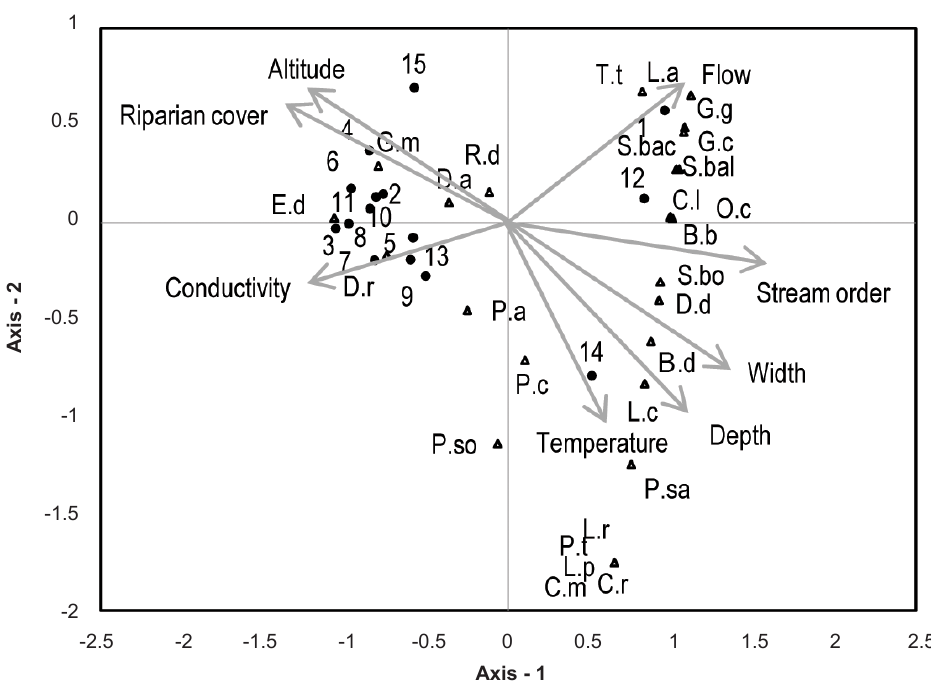
Figure 3. Canonical Correspondence Analysis (CCA) biplot depicting the distribution of fish species along the environmental parameters in 15 study sites in Panna landscape, Madhya Pradesh. [Site labels: 1- Gahrighat; 2- Gehranala; 3- Jamunahi; 4- Imalia; 5- Bargadi; 6- Mahuapani; 7- Keerpani; 8- Ghatera; 9- Nararan; 10- Kheriya; 11- Silatanala; 12- Magradabri; 13- Judinala; 14- Madla; 15- Pandav Falls. Species codes: B.d - Bangana dero ; B.b - Barilius bendelisis ; C.m - Cirrhinus mrigala ; C.r - Cirrhinus reba ; G.c - Gibelion catla ; D.r - Danio rerio ; D.a - Devario aequipinnatus ; D.d - Devario devario ; E.d - Esomus danricus ; G.g - Garra gotyla ; G.m - Garra mullya ; C.l - Crossocheilus latius ; L.a - Labeo angra